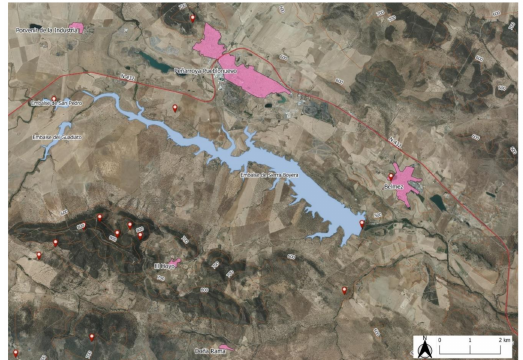
Figure 6. New archeological sites detected through remote sensing surveys in the area surrounding